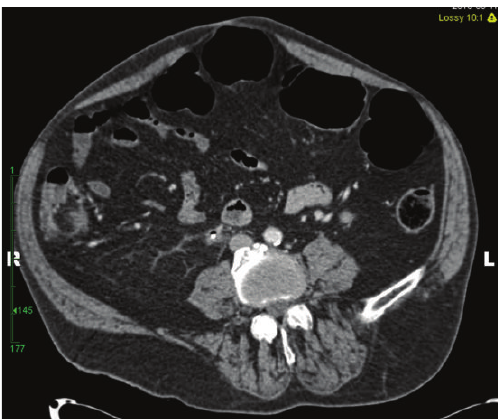
Figure 3: The CT image demonstrates a retained right ureteral stent and the presence of gas in the right ureter.